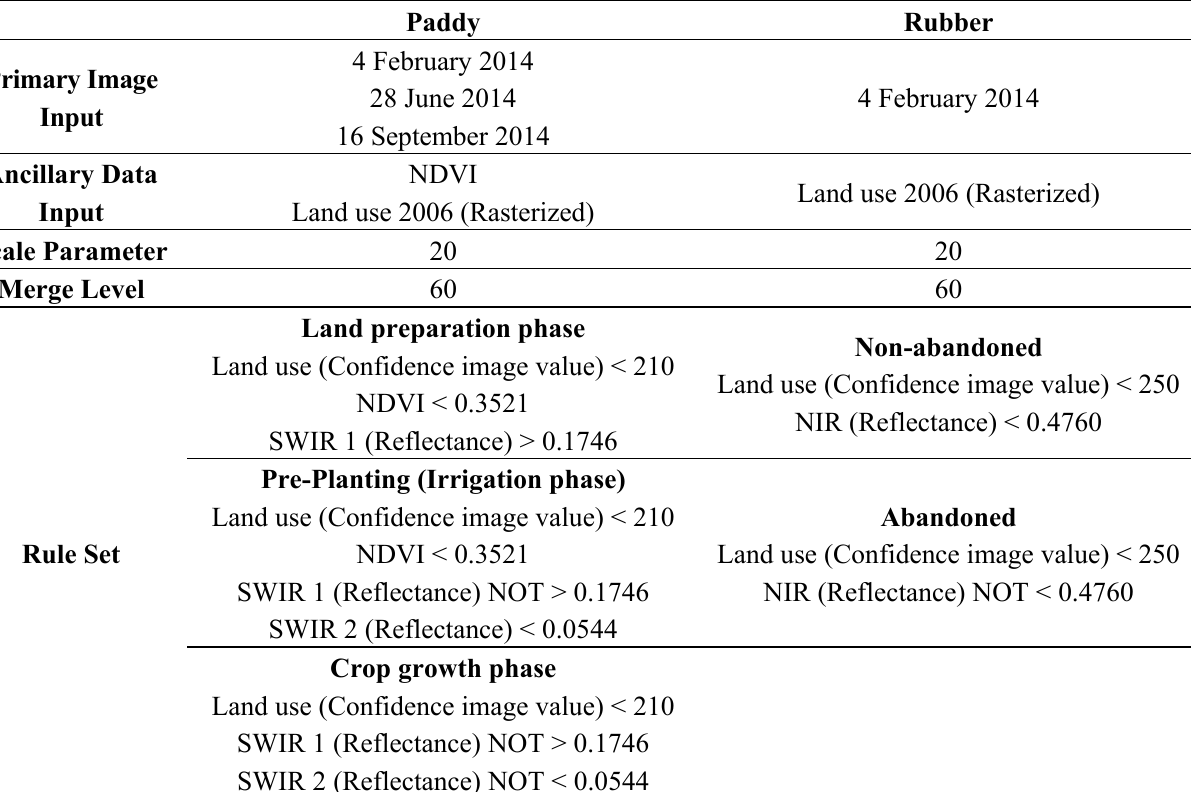
Table 2. The rule set protocol to classify abandoned and non-abandoned paddy and rubber.